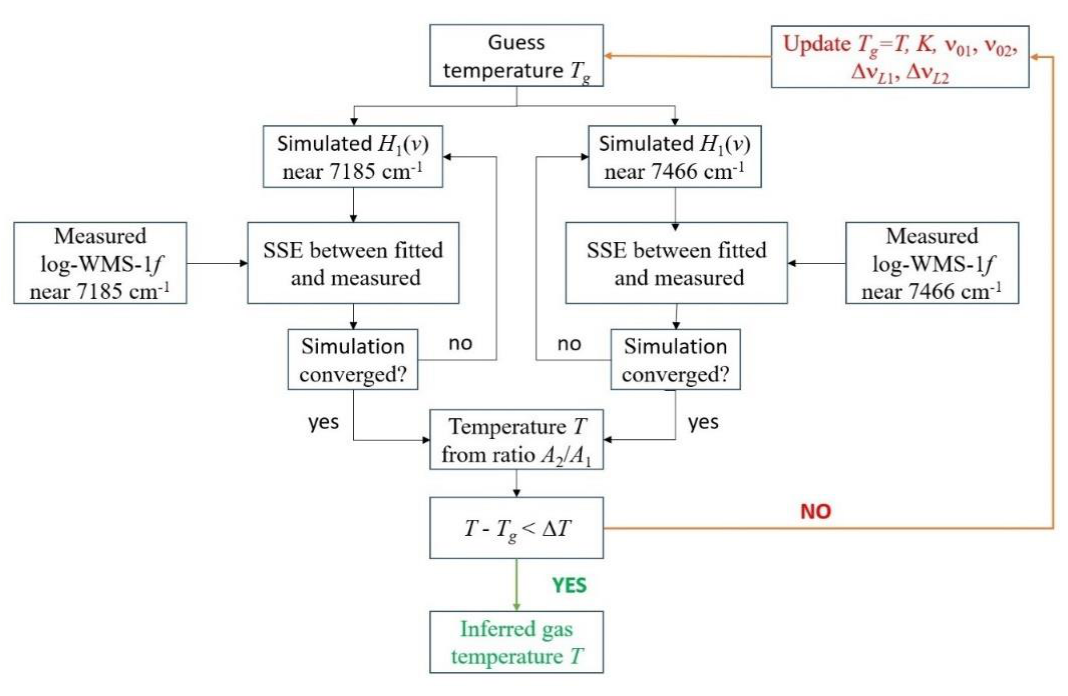
Figure 6. Flow chart for the second algorithm for inferring the temperature from the measured spectra.